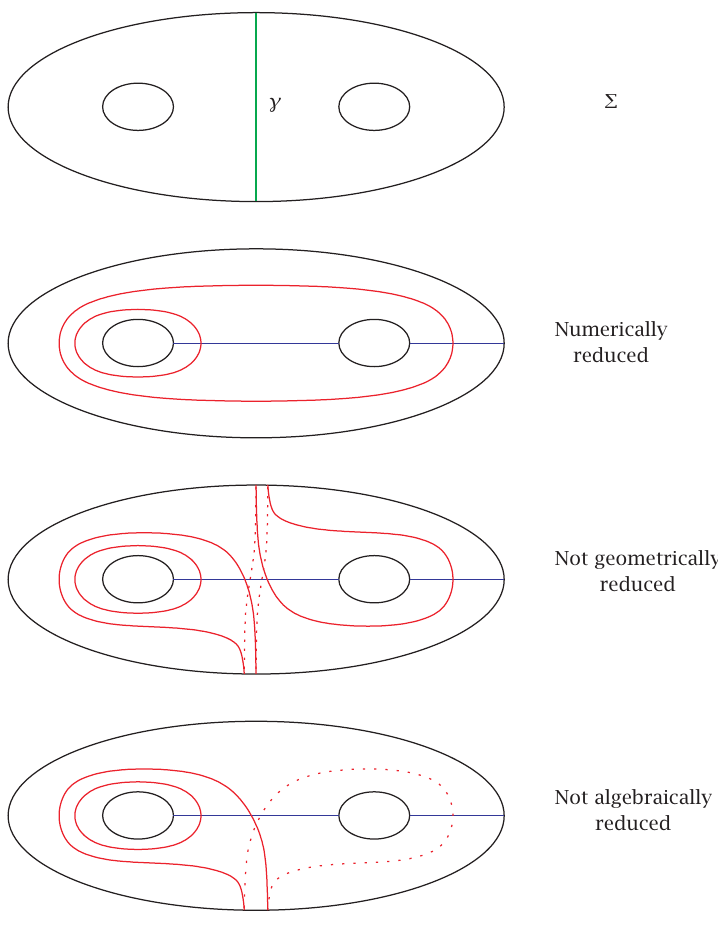
Figure C.1 . Three HMS